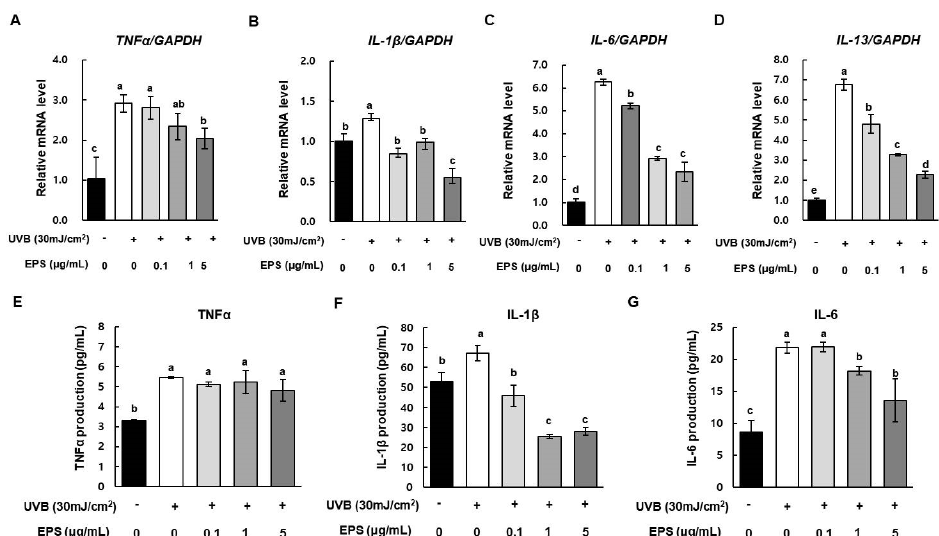
Figure 7. Effect of HY7714 EPS on pro-inflammatory cytokines in UVB-irradiated HS68 cells. ( A ) Relative mRNA expression levels of ( A ) TNF α , ( B ) IL-1 β , ( C ) IL-6 , and ( D ) IL-13 in HS68 cells were measured by qPCR and normalized against GAPDH . Relative levels of intracellular ( E ) TNF α , ( F ) IL-1 β , and ( G ) IL-6 in medium of HS68 cells treated with HY7714 EPS were measured using commercial ELISA kits. Data are expressed as means ± SD ( n = 4), and values labeled with different letters are significantly different, p < 0.05 (a > b > c > d > e).